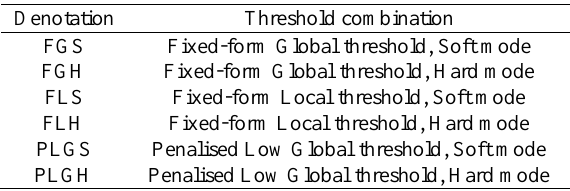
Table 1. Denotation of threshold values and modes used in the following figures. Figure 5. Fixed-form global and local, and penalised low global threshold values for the DWT and SWT decomposition.